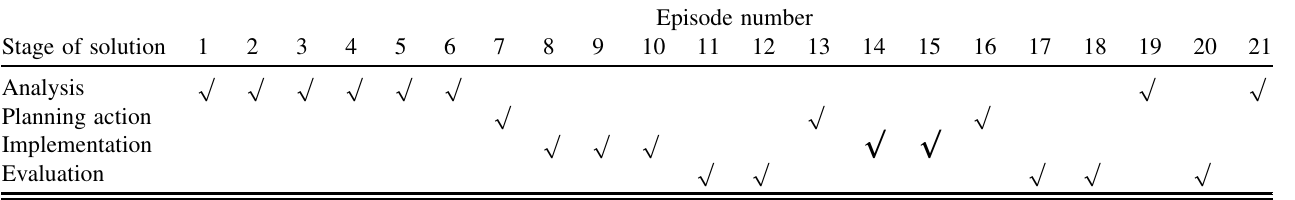
TABLE II. Workshop A (minimal guidance): Episodes mapped to pedagogical problem-solving steps. Implementation consists of both the development of instruction and materials as well as carrying those out in the classroom. In all tables, bold check marks refer to the classroom implementation.